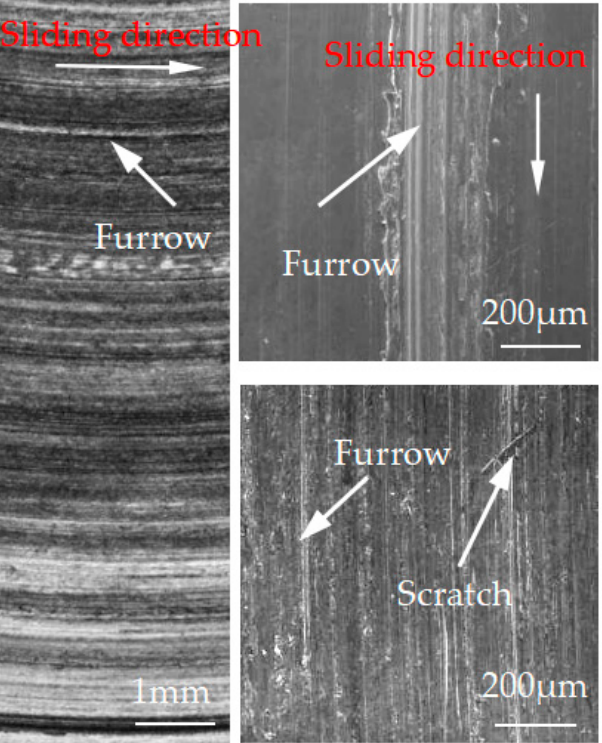
Figure 13. Surface morphology of the disc material after intermittent braking at an ambient temper- ature of 0 °C.